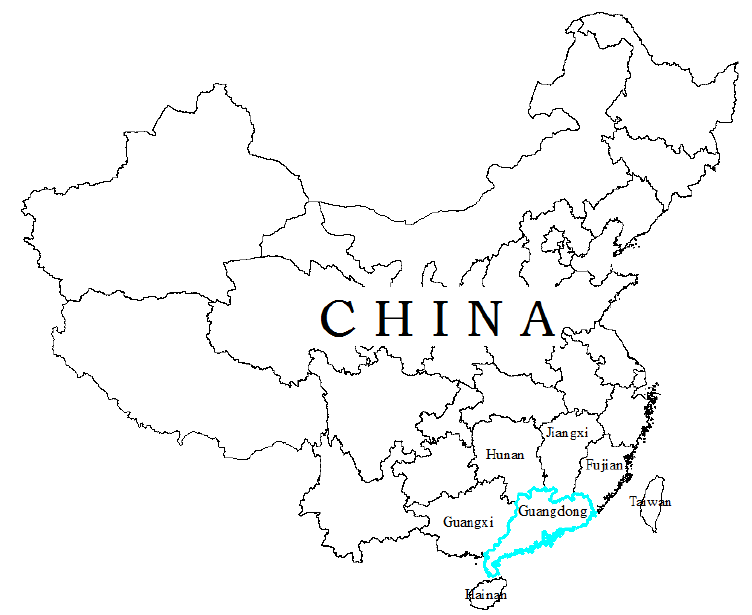
Figure 1. Geographic location of Guangdong province in